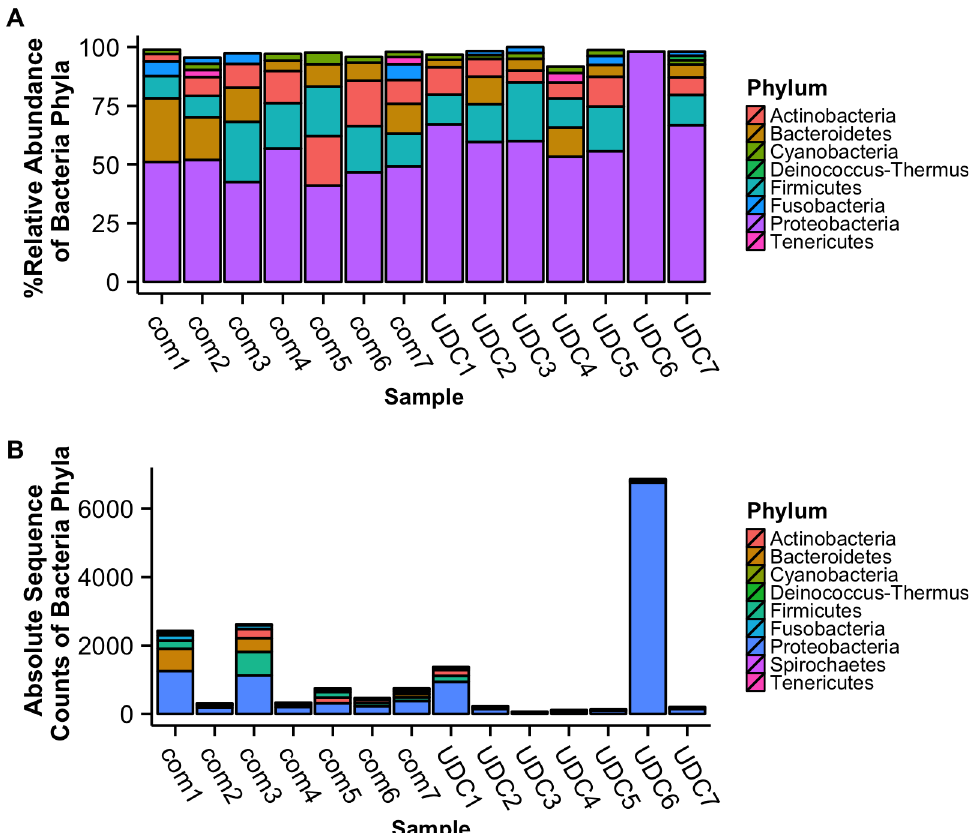
Fig 2. Microbial phyla associated with stranded harbor seal brain tissues. (A) Relative abundance of bacterial phyla with > 1.5% relative abundance samples and (B) bacterial phyla with > 10 absolute sequence counts from comparative (com) and unknown cause of death